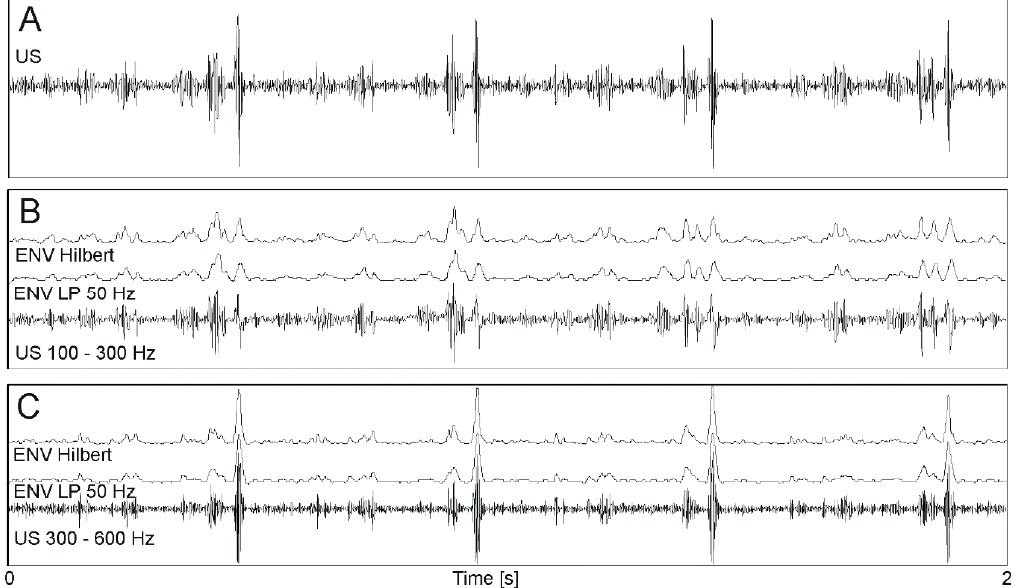
Figure 4. Doppler ultrasound signal processing. ( A ) original signal after demodulation; ( B ) signal after band-pass filtering 100 ÷ 300 Hz (wall movements) and two envelopes determined using 50 Hz low-pass filter and the Hilbert transform; ( C ) signal after band-pass filtering 300 ÷ 600 Hz (valve movements) and two envelopes as in B.